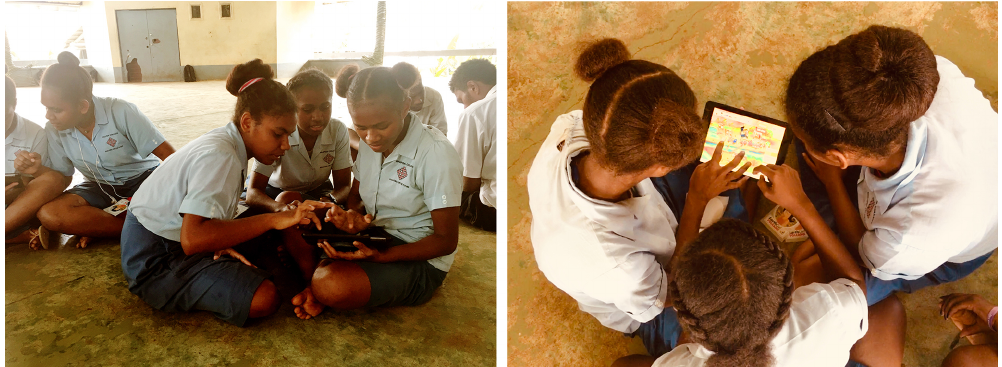
Figure 13. Malapoa College students in Vanuatu test play Earth Girl Volcano on a tablet and discuss possible strategies for a specific location. Photo by Isaac